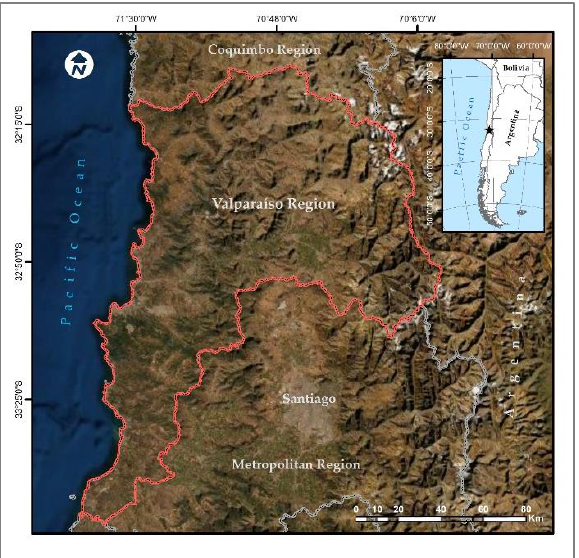
Figure 2. Map showing the area where the prioritization was performed. The Valparaiso Region is shown with a red border